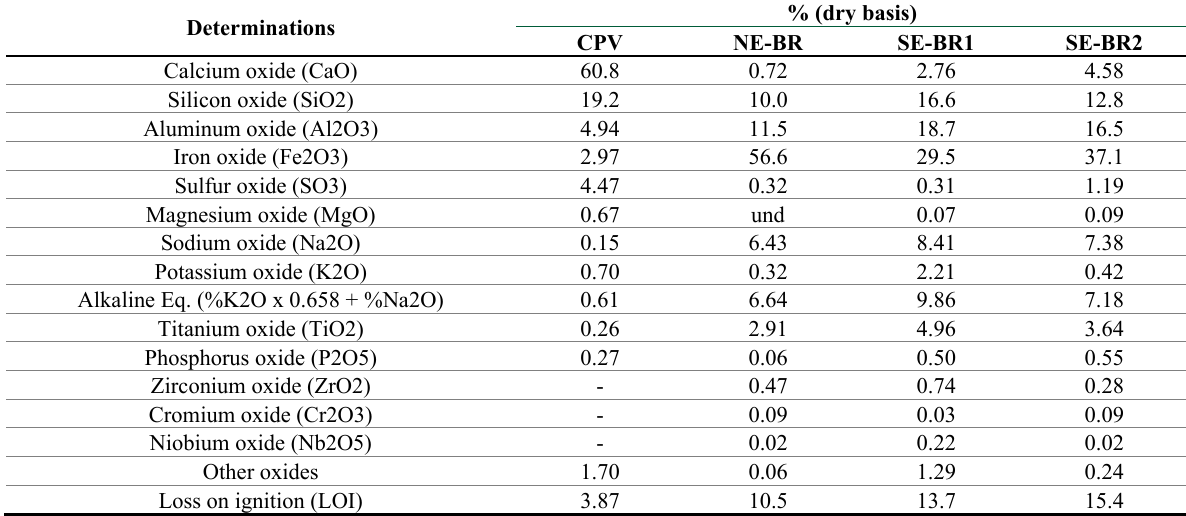
Table 2 C hemical composition of Portland cement and bauxite residues.